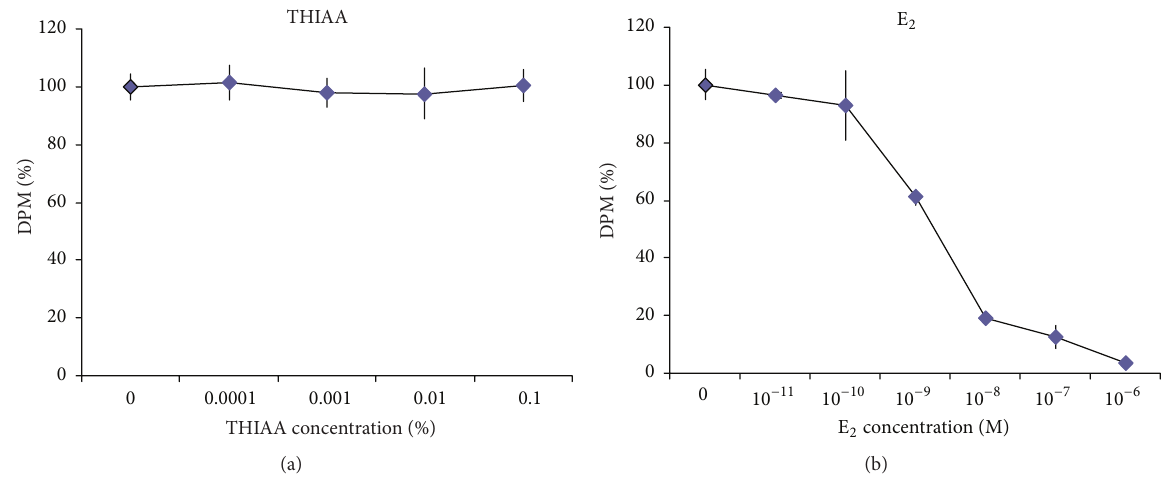
Figure 10: Effect of THIAA on [ 3 H]E 2 -ER 𝛼 complexation in MCF-7 cells. MCF-7 cells were incubated during 40 minutes with 10 −9 M [ 3 H]E 2 and increasing concentrations of THIAA (a) or E 2 (b). Whole cell [ 3 H]E 2 binding capacity was assessed by liquid scintillation counting. Data (mean ± SD) refer to a representative experiment performed three times in triplicate.